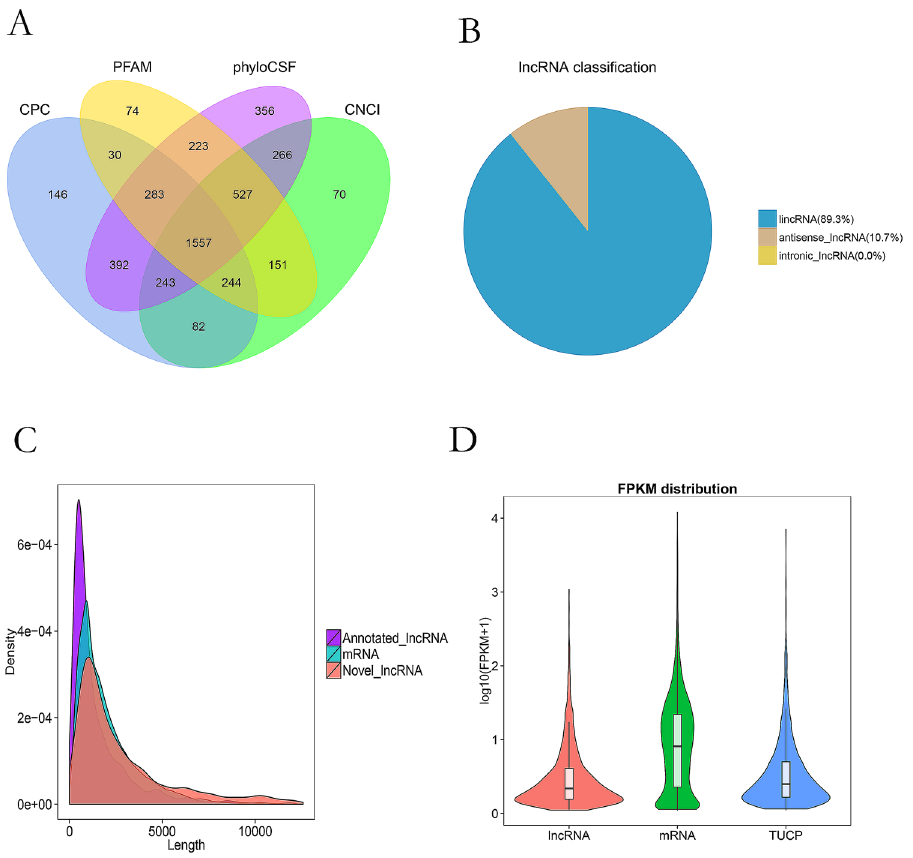
Figure 1. Identification and characterization lncRNAs and mRNAs in M2 follicles. ( A ) Identification of non- coding lncRNAs by using four tools-CPC, PFAM, phyloCSF and CNCI; ( B ) lncRNAs classification; ( C ) The length of lncRNAs and mRNAs; ( D ) Violin plot of expression abundance (showed in log10 (FPKM + 1)) for mRNAs and